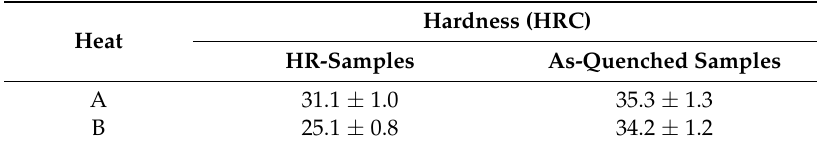
Table 2. Hardness of Heats A and B in hot rolled (HR) and oil quenched (OQ) conditions.